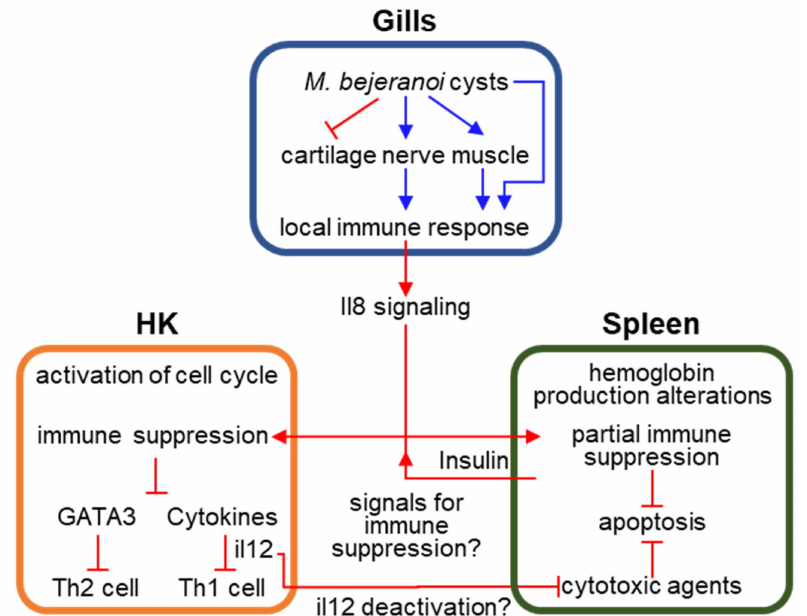
Figure 7. A Model illustrating the key findings and open questions regarding Myxobolus bejeranoi infection of hybrid tilapia. M. bejeranoi sporulation takes place in the gills within encapsulated cysts. The cysts, which are located on striated muscles at the base of the gill filament, trigger modifications in local nerve, muscle, and cartilage. As infection severity increases, the immune system is activated. We hypothesize that a signal is sent from the gills to the hematopoietic organs HK and spleen, leading to a systemic immune suppression. While a cytokine with domains of interleukin 8 (il8) was up-regulated in all examined tissues, the fundamental question regarding the nature of this signal remains unanswered. In HK, cell cycle processes are activated, while the immune system is suppressed. Suppression includes deactivation of the master regulator transcription factor GATA3 , which leads to less differentiation of Th2 cells and deactivation of cytokines. Amongst the latter is interleukin 12 (il12), whose inactivation leads to decrease in Th2 cells differentiation and may induce down-regulation of cytotoxic agents (perforin, granzyme B) in natural killer cells in the spleen. Thus, deactivation of these cytotoxic agents may lead to decrease in apoptosis. Spleen exhibited alterations in the erythrocyte machinery and hemoglobin production. Insulin levels were highly increased in the spleen, suggesting that this immunomodulatory hormone may further signal for immune